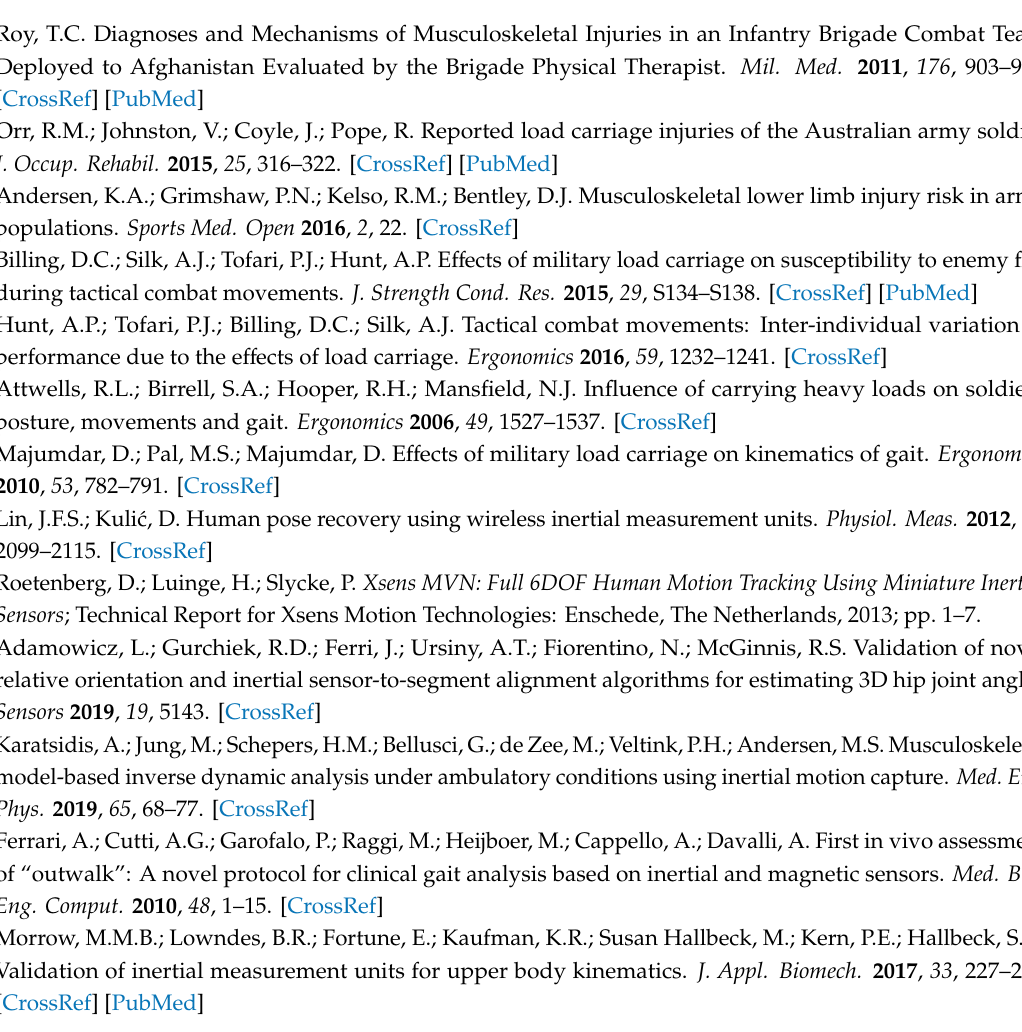
Table S1: OPT and Xsens time series marker trajectories used for PCA, Table S2: OPT and Xsens tracking markers used for Visual 3D biomechanical